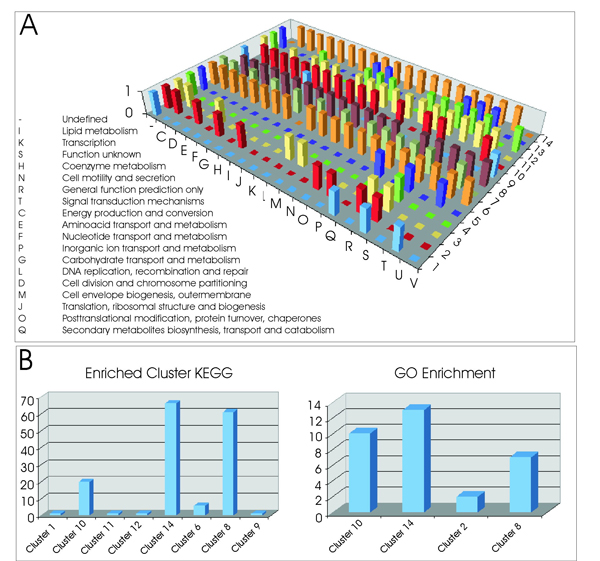
COG, KEGG and GO categories enrichment across the 14 k-means clusters. Panel A: Presence (coded 1) or absence (coded 0) of enriched COG categories for each cluster. Panel B: numbers of KEGG and GO enriched classes for each cluster.